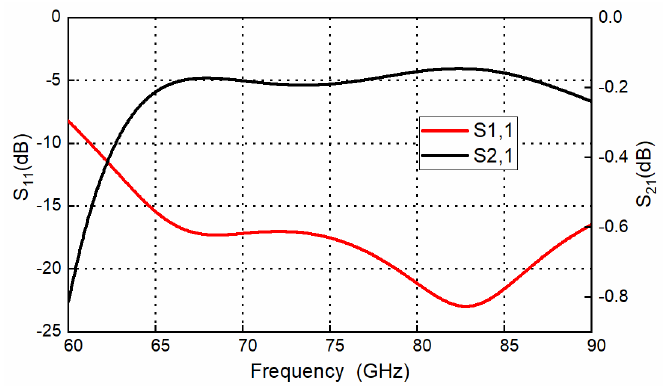
Figure 11. Simulated frequency response of the designed E-band transition.